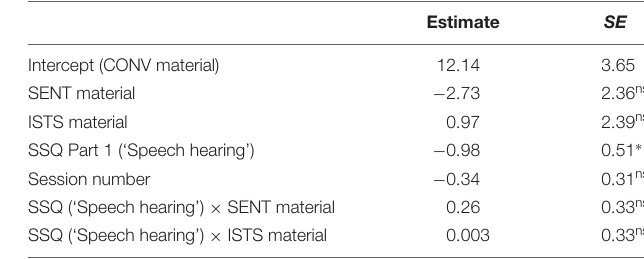
TABLE 6 | Coefficients of repeatability (in dB) for ANL for the six speech materials and the two test sessions contrasting subsequent repetitions. Test material